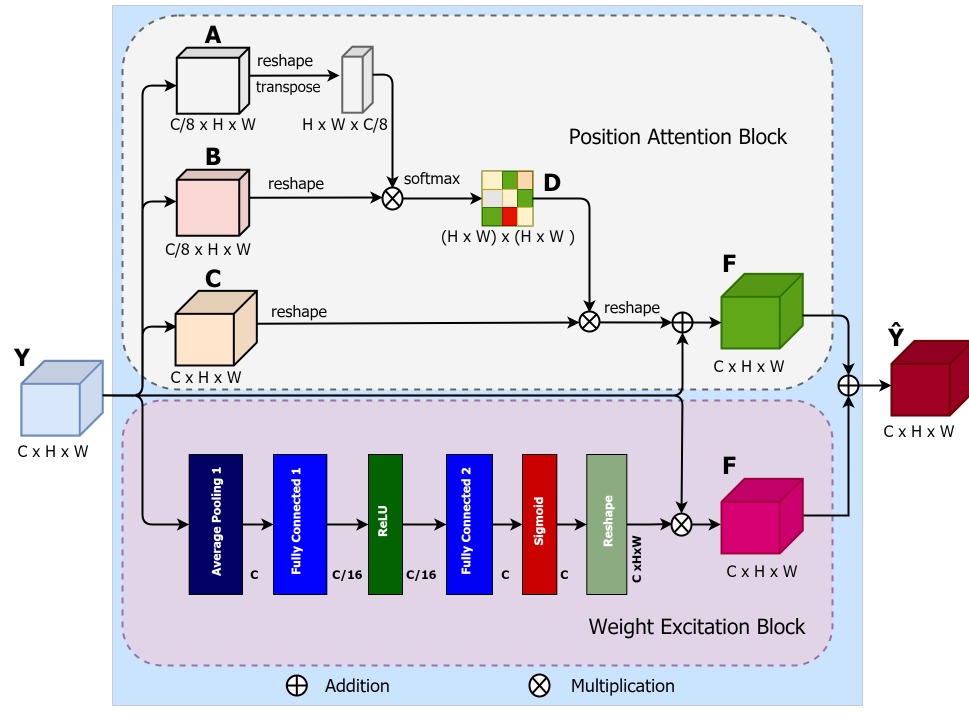
Figure 4. Illustration of the proposed PAWE